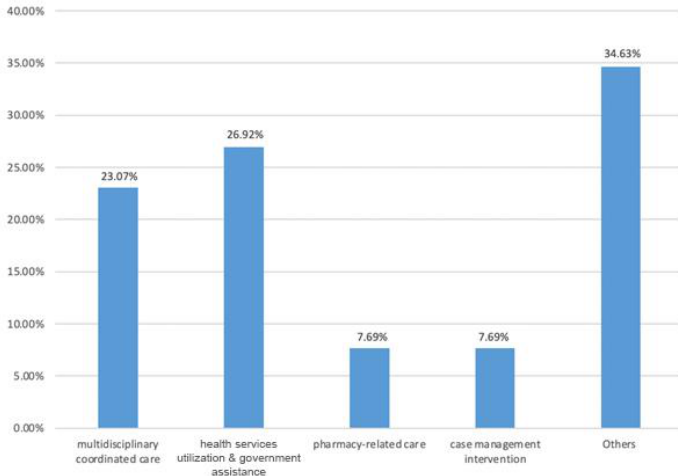
Figure 4. The percentage of studies using each type of intervention.